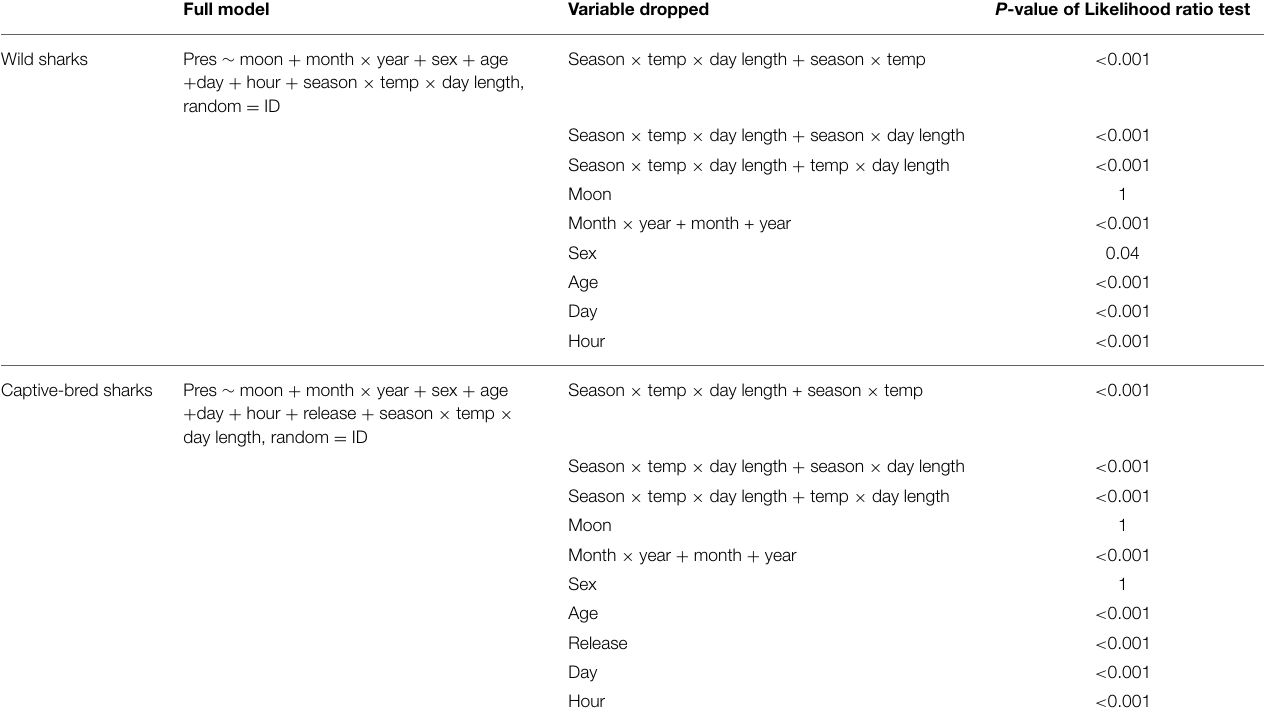
TABLE 1 | Results of GLMM model selection using likelihood ratio tests for all